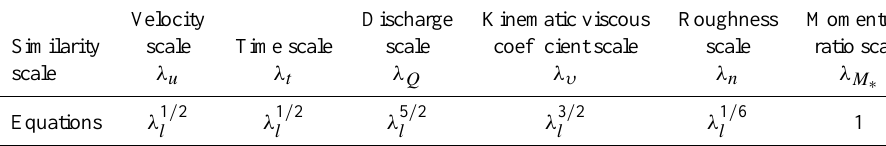
Table 1. Scale for the confluence of debris flow and the main river.